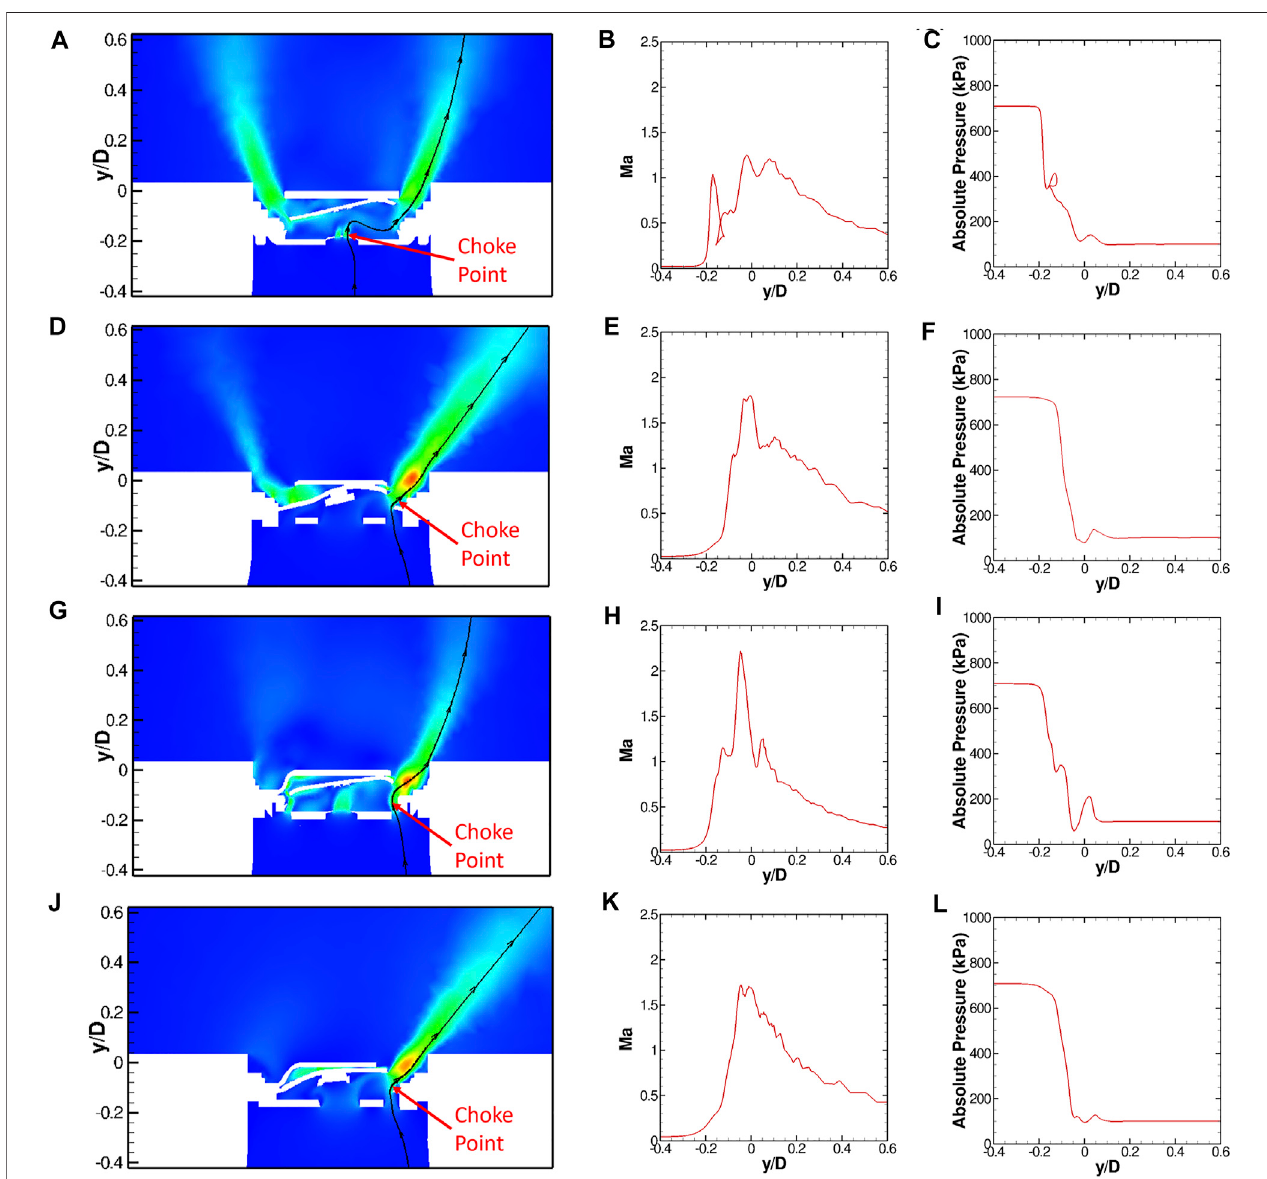
FIGURE 8 | RANS simulated Mach number distribution at P 1 /P 2 (cid:1) 7 with a streamline passing through the right vent hole, along with Mach number and absolute pressure extracted along the streamline for: MTI (A , B , and C) , LG MJ1 (D , E , and F) , K2 (G , H , and I) , and LG M36 (J , K , and L) caps.